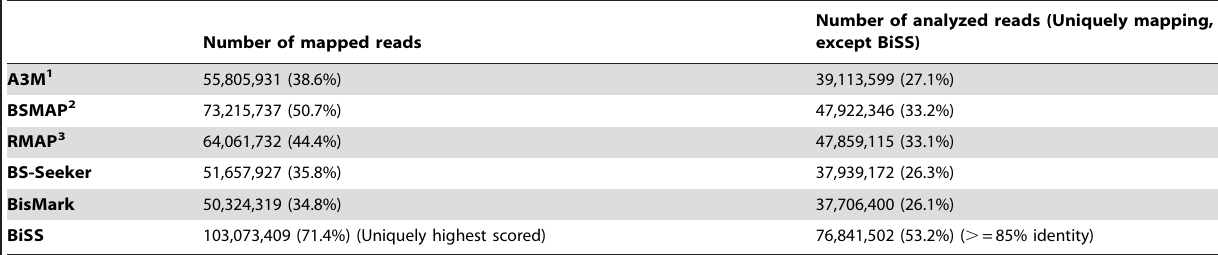
Table 1. Comparison of mapping results for BiSS and selected other aligning programs 1 .